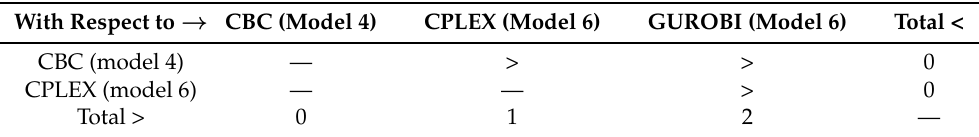
Table 4. Comparison of fastest models for each solver to solve a small instance (two agents, ten jobs) with unpaired two-sample Wilcoxon tests.